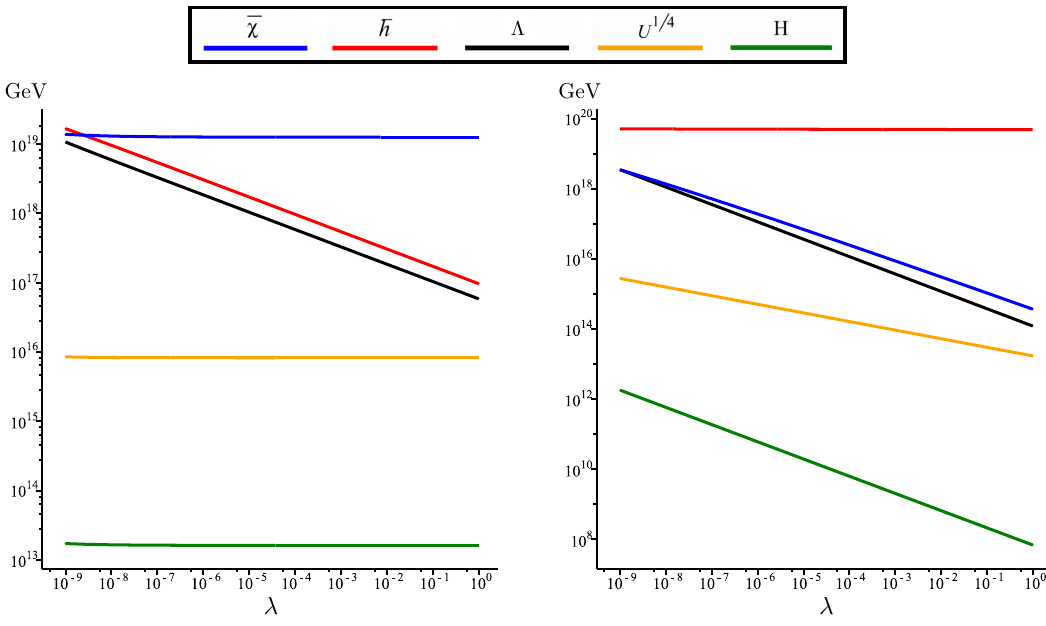
  Figure 2 . Different scales at the CMB pivot scale as a function of the Higgs quartic coupling λ in the metric formulation (left) and the Palatini formulation (right). The line styles are the same as in figure